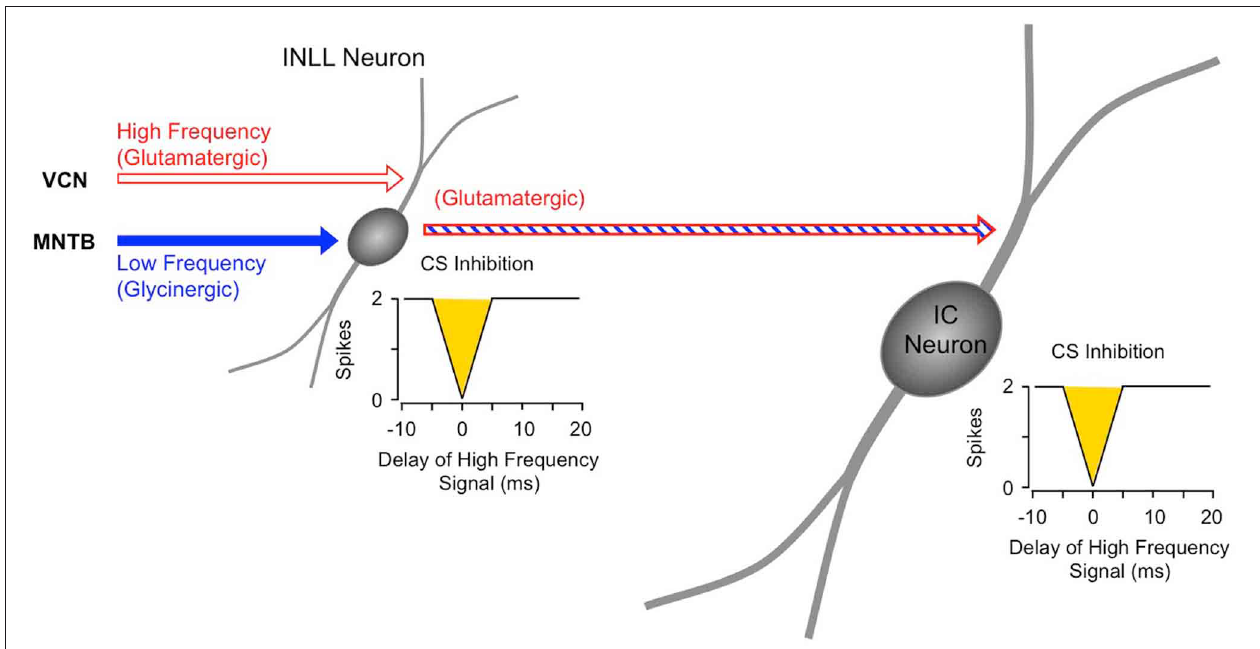
FIGURE 8 | Schematic diagram of circuitry underlying combination-sensitive inhibition in INLL and IC. The red and blue striped arrow indicates sensitivity to both low and high-frequency